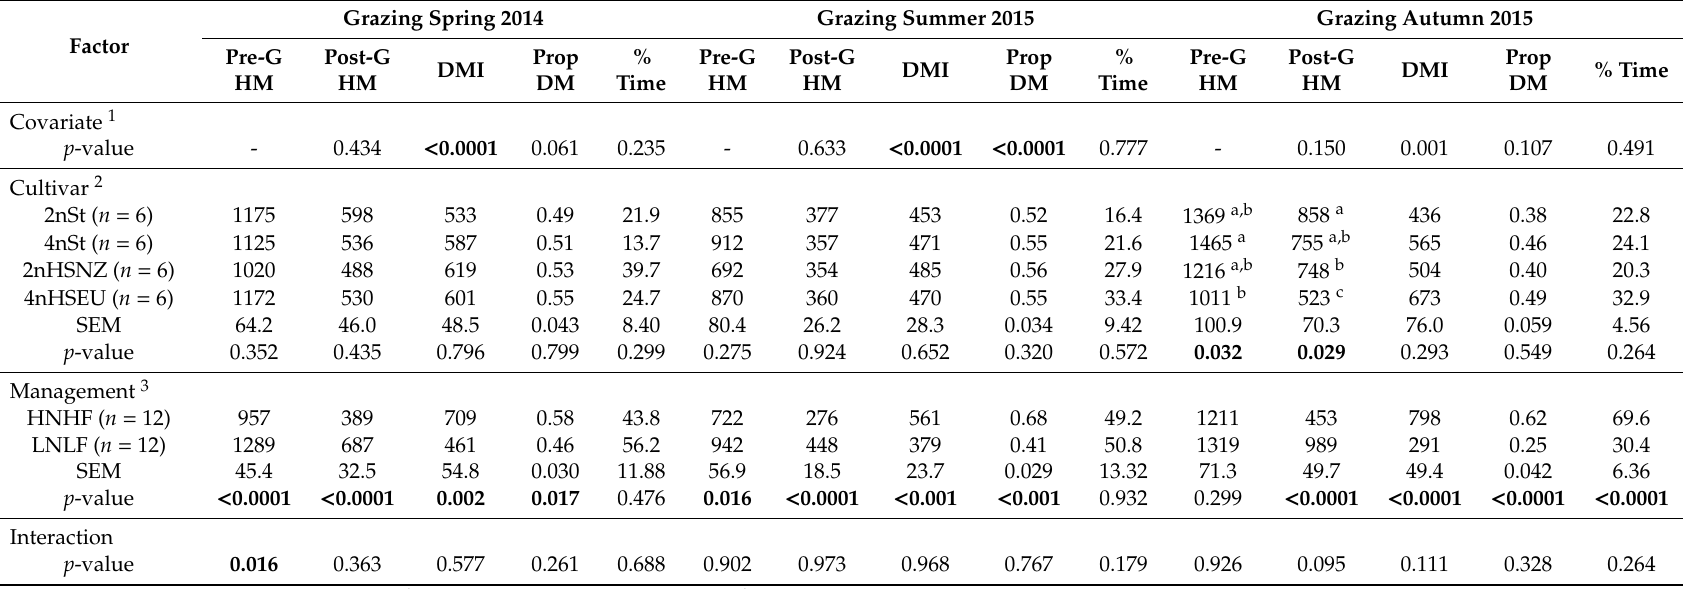
Table 4. Pre- and post-grazing herbage mass, apparent DMI, proportion of DM harvested and the percentage of grazing time for the pastures of four Lolium perenne L. cultivars under two agronomic managements grazed by six dairy cows during three grazing assessments (spring, summer and autumn).